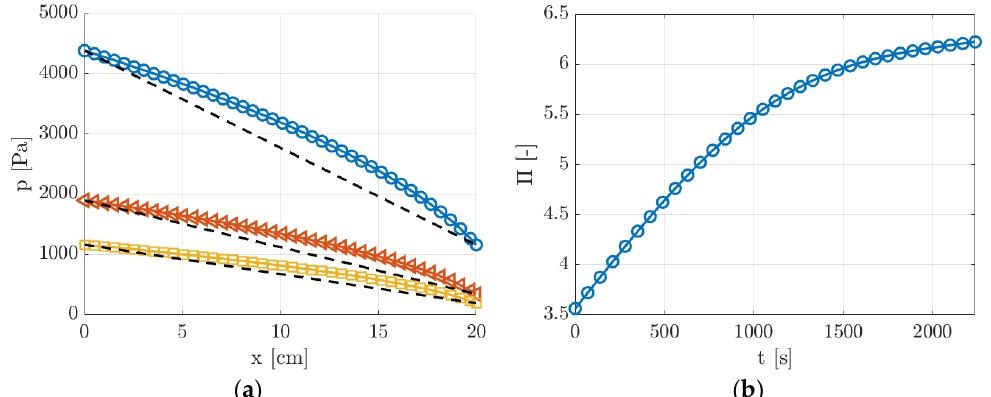
Figure 12. ( a ) Pressure distribution 𝑝(𝑥,𝑡) along the channel length at three different times 𝑡 = 100, 1000, and 2000 s during the experimental run, which correspond to pressure ratios Π = 3.8 (O), 5.5 ( (cid:3) ), and 6.2 ( ☐ ). The dashed lines represent the linear pressure distributions when rarefaction and compressibility effects are neglected; ( b ) time evolution of pressure ratio Π during the experimental run.